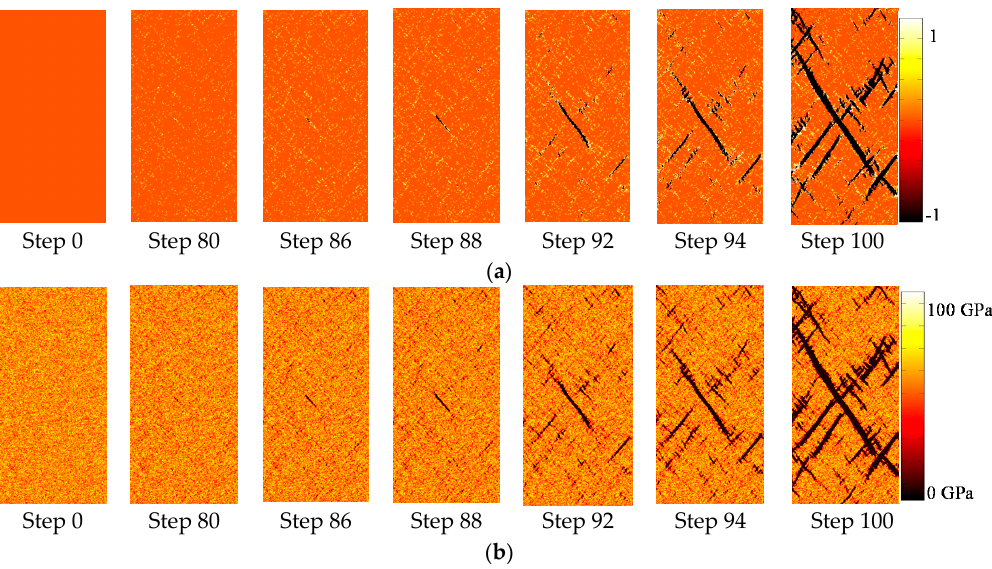
Figure 3. The damage and failure process of the two-dimensional numerical sample during uniaxial compressive test: ( a ) Damage variable evolution; ( b ) elastic modulus evolution.